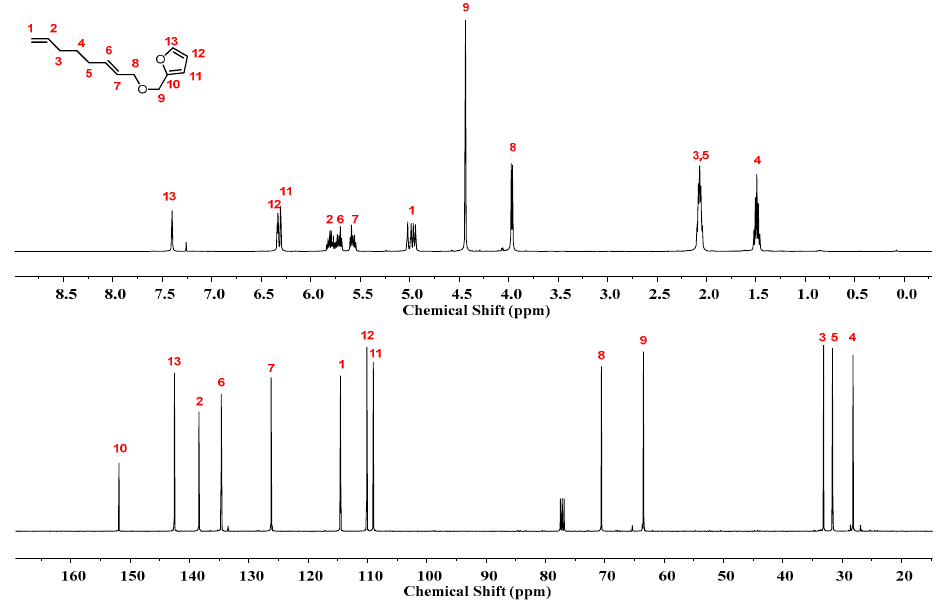
Figure 1 . 1 H NMR and 13 C NMR spectra of OC8-FUR .